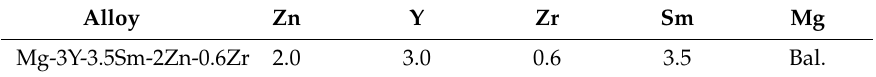
Table 1. Nominal chemical composition of the as-cast Mg-3Y-3.5Sm-2Zn-0.6Zr alloy (wt %). Alloy Zn Y